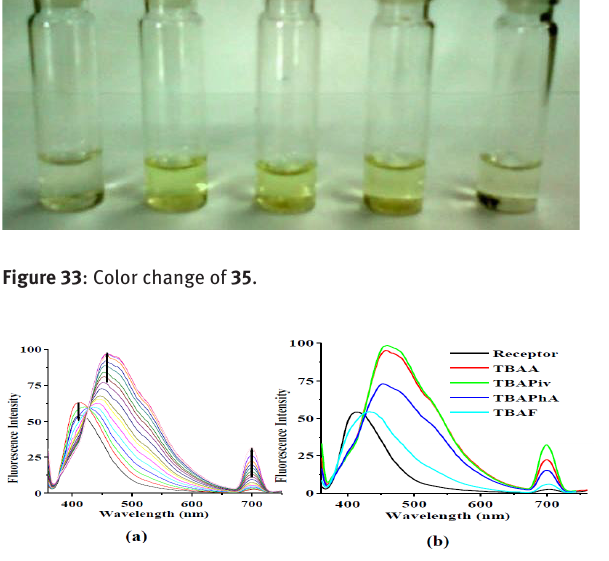
Figure 34: (a) Change of fluorescence intensity of 35 on gradual addition of tetrabutylammonium acetate in CH3CN; (b) enhancement